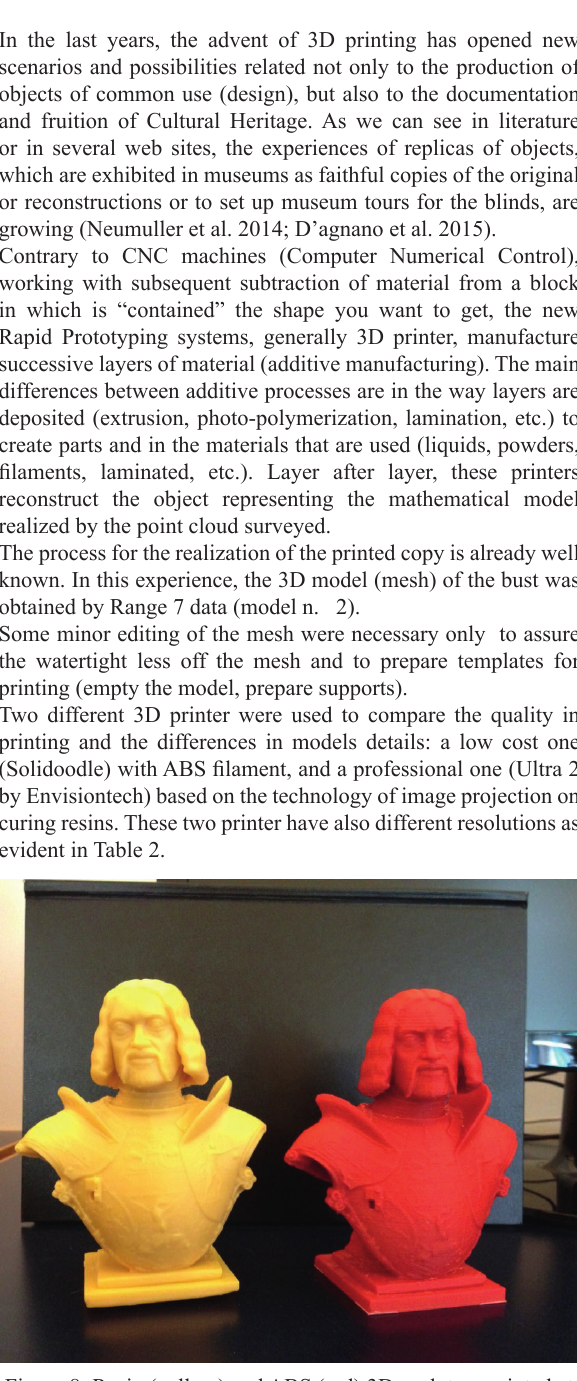
Figure 8: Resin (yellow) and ABS (red) 3D sculpture printed at scale 1:5